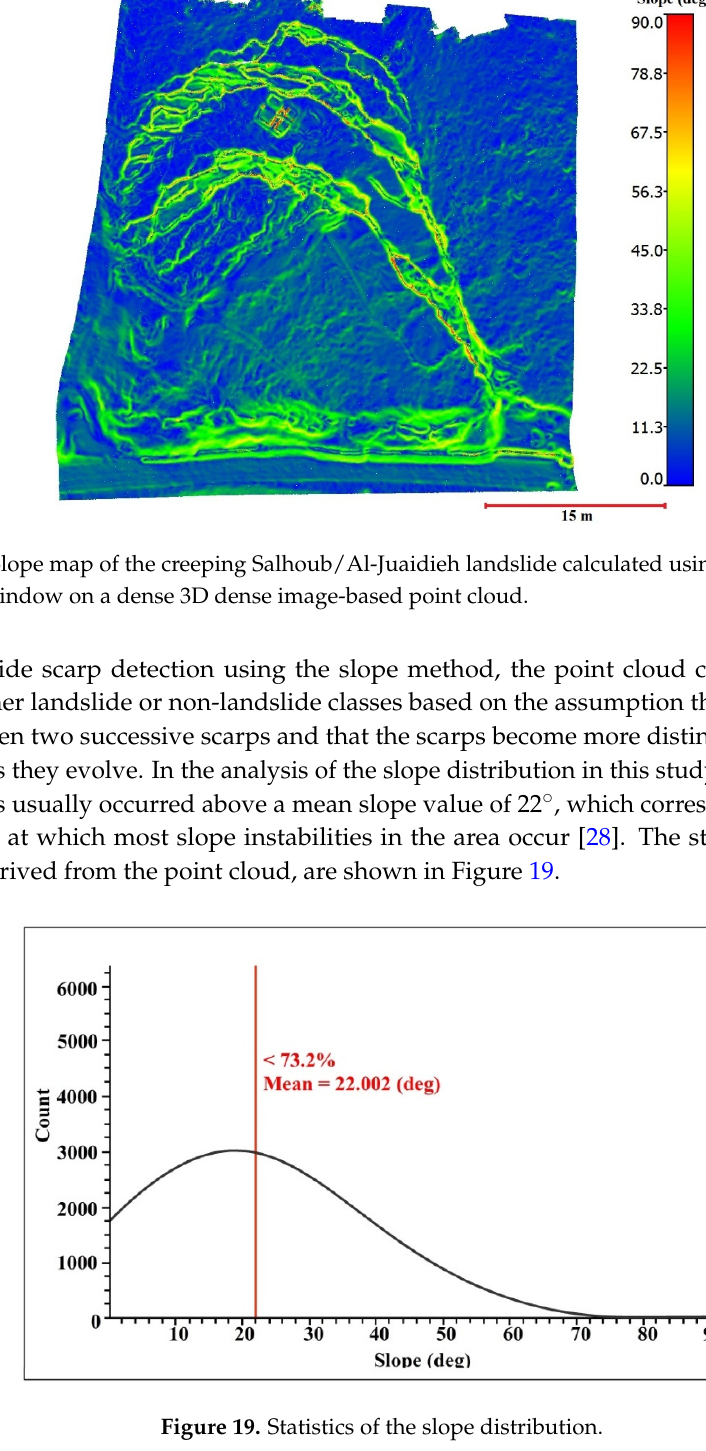
Figure 19. Statistics of the slope distribution.